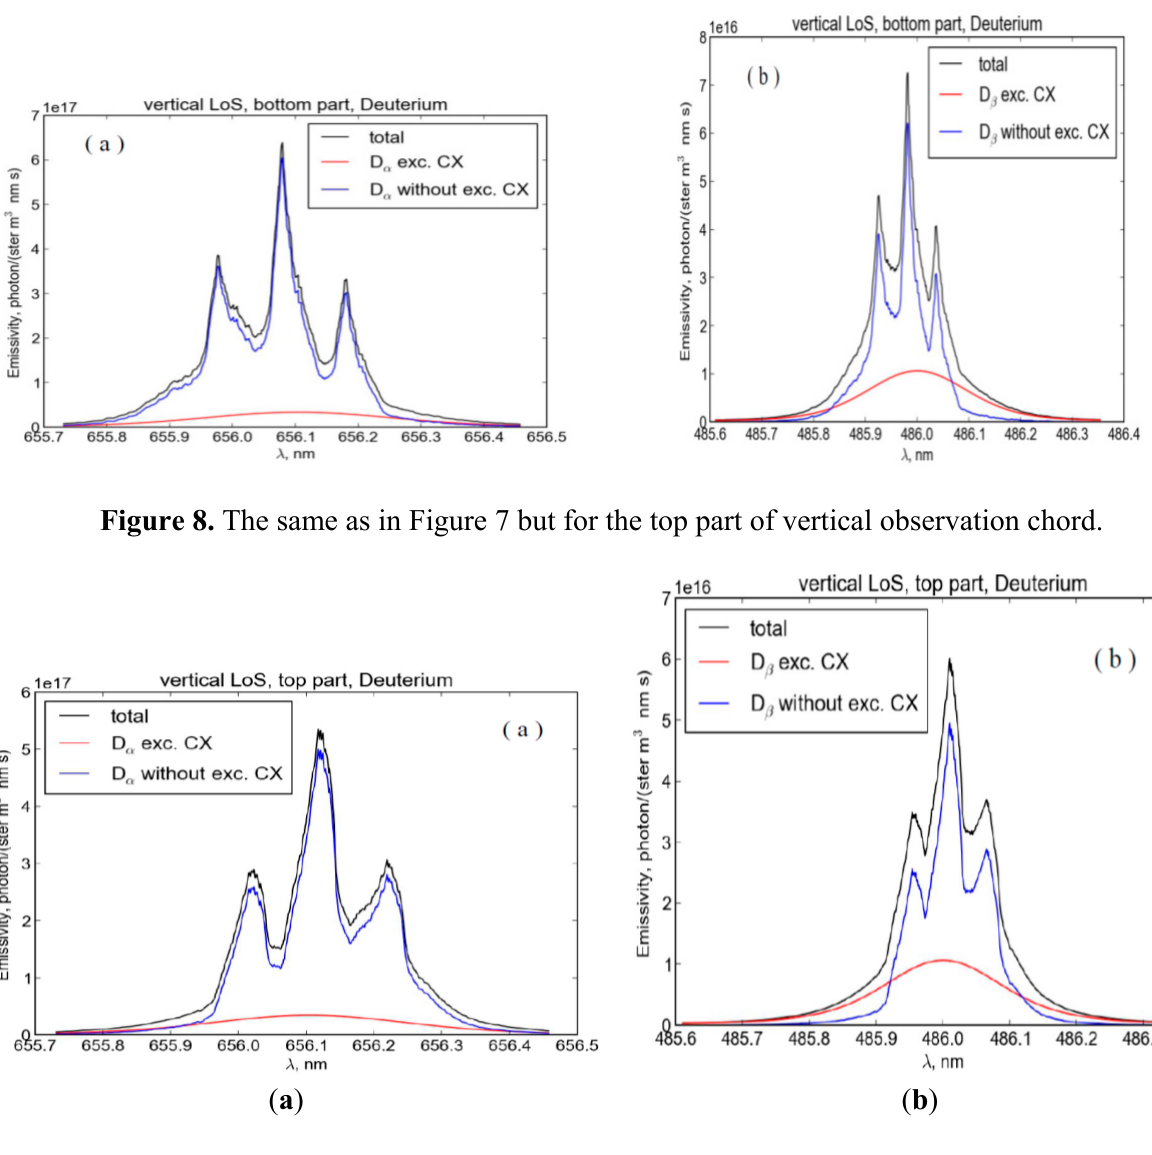
Figure 7. Spectral intensity of Balmer-alpha ( a ) and Balmer-beta ( b ) deuterium lines in SOL for the bottom part of vertical observation chord ( R = 65.5 cm) for the ITER SOL&divertor case #1514. The red line shows contribution to the radiation from neutrals obtained from charge exchange of neutrals in the exited state n = 3 (for the Balmer-alpha line) and n = 4 (for the Balmer-beta line) on fast ions. Blue lines—from ballistic atoms. Black line is the total spectrum.